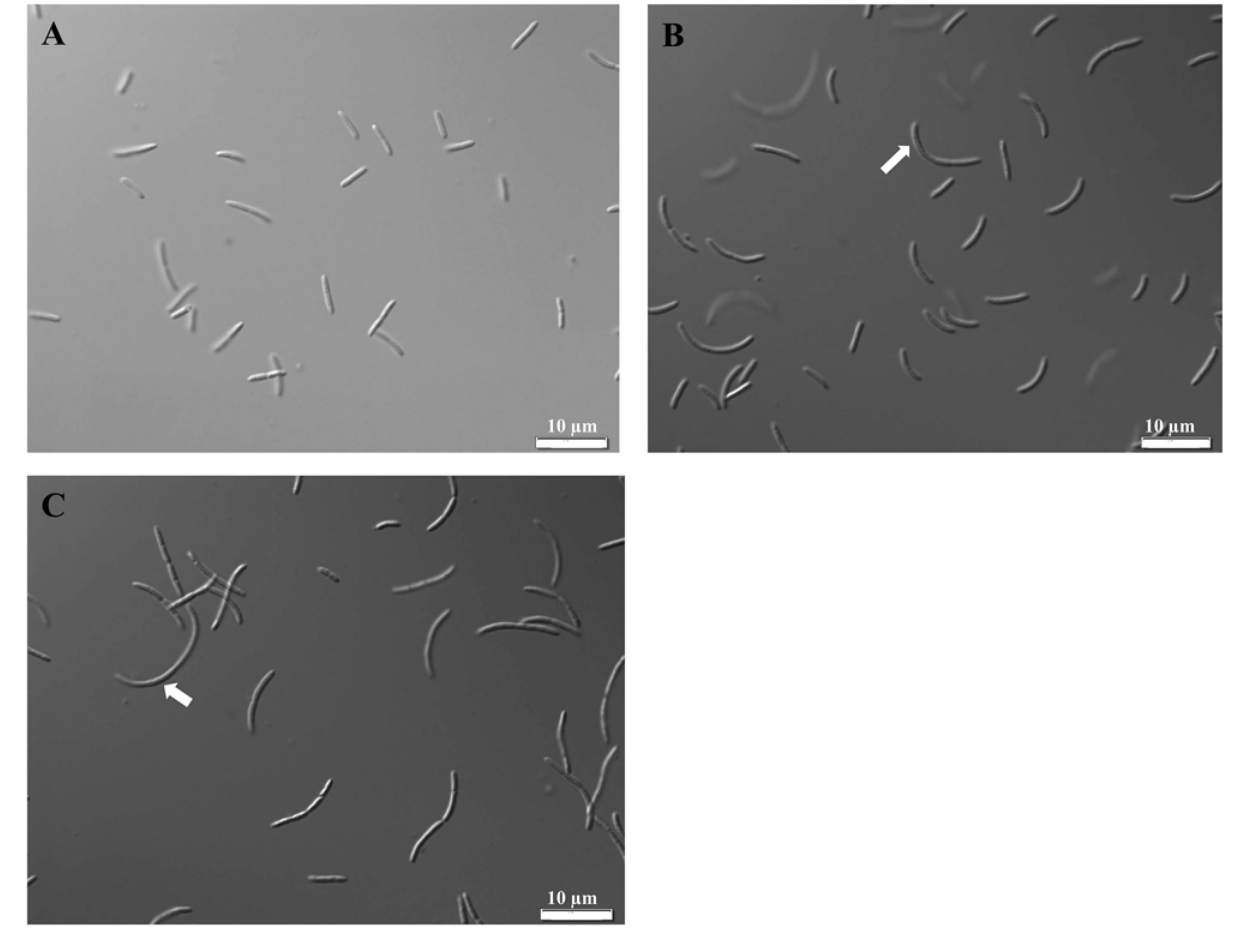
Fig 6. Microscopic images of cells of wild type (A), mutant I-23 (B) and mutant #52 mutant (C). Wild-type cells are rod-shaped, whereas cells of both mutants are curve-shaped, indicated by white arrows. The magnitude of magnification is